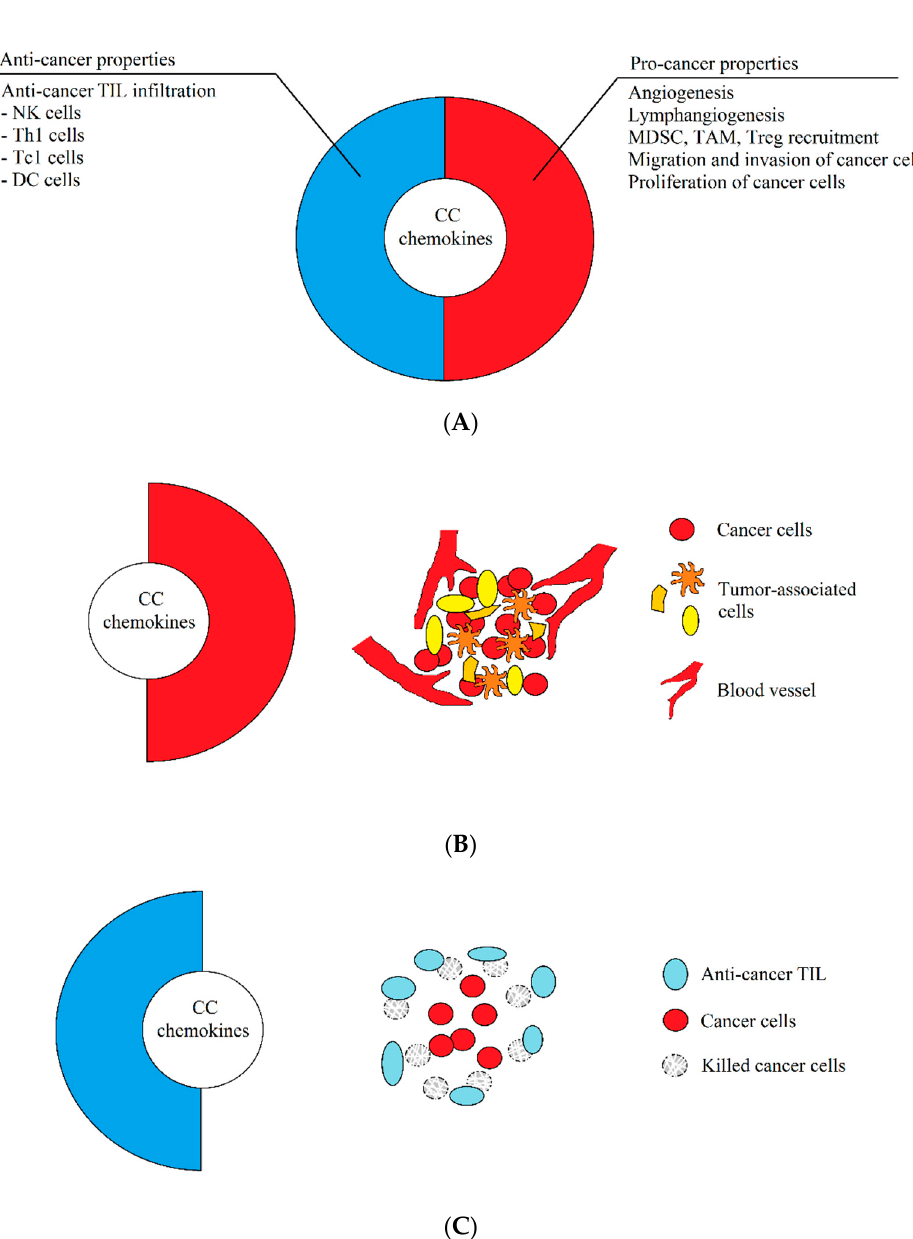
Figure 1. The dual properties of CC chemokines. ( A ) Most, if not all, the chemokines described in this paper have both pro- and anti-cancer properties. The anti-cancer properties consist of the recruitment of anti-cancer tumor-infiltrating lymphocytes (TIL), which infiltrates the tumor and destroys tumor cells. The pro-cancer properties of chemokines, on the other hand, consist in causing angiogenesis and lymphangiogenesis, recruitment of pro-cancer cells supporting the development of the tumor, and the stimulation of proliferation, the induction of migration, and the invasion of cancer cells. ( B ) In a growing tumor, CC chemokines have enhanced pro-cancer properties, while anti-cancer properties are suppressed. As a result, these chemokines participate in the development of a tumor by causing angiogenesis, migration of tumor cells, and recruitment of cells supporting the development of a tumor, which results in the progress of cancer. ( C ) During immunotherapy or an effective anticancer response of the immune system, the same CC chemokines show enhanced anti-cancer properties, which result in the infiltration of a tumor by anti-cancer TIL, which destroy tumor cells. The immune system fights with the tumor, which often leads to recovery.